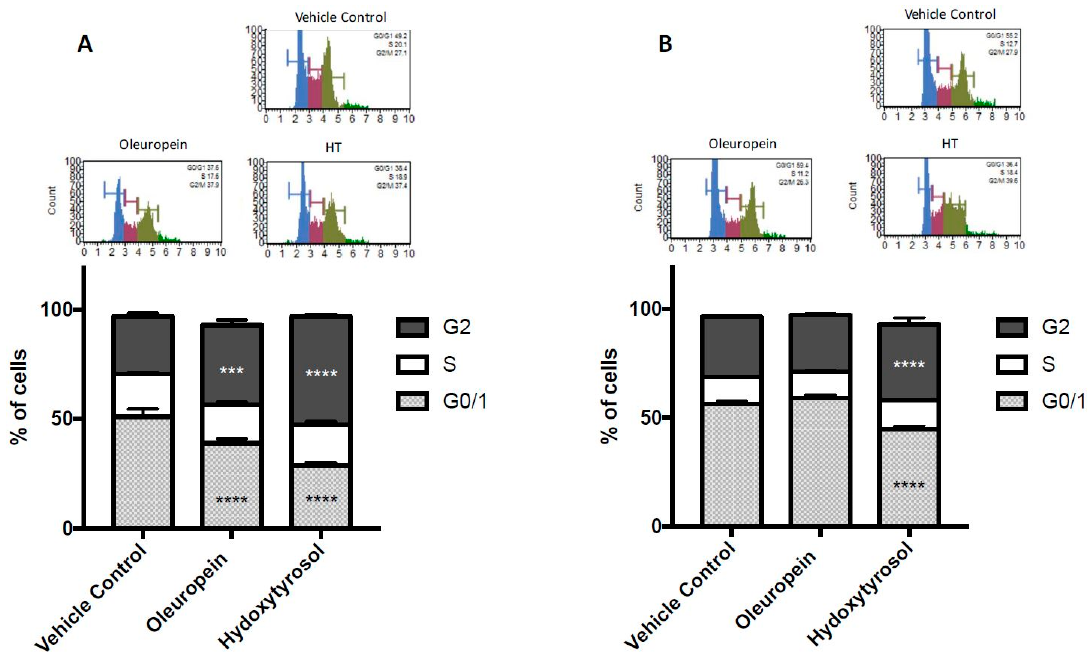
Figure 3. Cell cycle analysis of MIA PaCa-2 ( A ) and HPDE ( B ) cells treated with oleuropein (200 µM) and hydroxytyrosol (100 µM) for 24 h. Bar graphs show the percentage of cells in G0/1, S and G2 phase of the cell cycle measured by MUSE cell cycle analysis kit. A representative DNA content profile for vehicle control, oleuropein and hydroxytyrosol (HT) treatment is pictured for MIA PaCa-2 ( A ) and HPDE ( B ) cells. Ordinary two-way ANOVA and Tukey’s multiple comparisons test compare the percentage of treated cells (oleuropein or hydroxytyrosol) in each stage of the cell cycle to vehicle control. **** p < 0.0001.